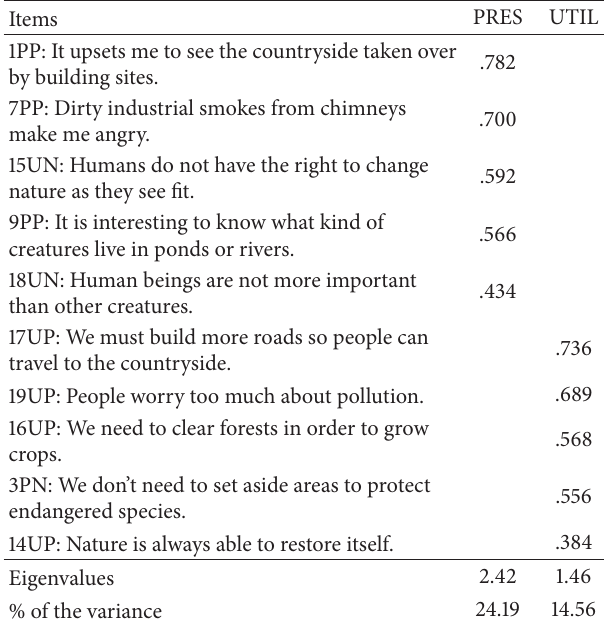
Table 1: Exploratory factor analysis for the 2-MEV for 10 items, 𝑁 = 190